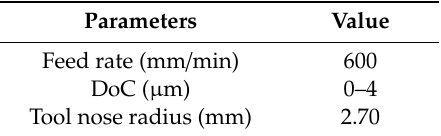
Figure 2. The tapper straight-cutting experiment. ( a ) Nanotech 350 CNC machine; ( b ) experiment setup; ( c ) diamond tool; ( d ) grooves. Table 1. Cutting conditions of the straight-cutting experiment.